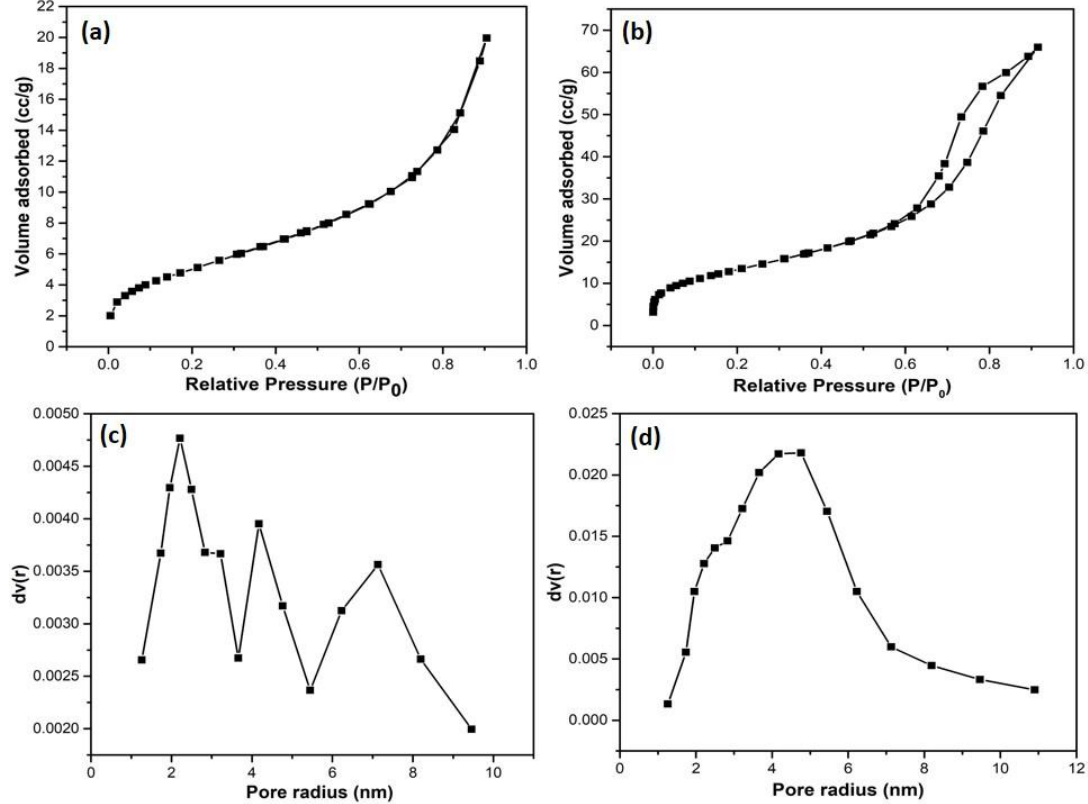
Figure 5. N 2 adsorption–desorption isotherm of ( a ) Bi 2 WO 6 and ( b ) Bi 2 WO 6 / C-dots / TiO 2 . BJH curve displaying pore size distribution of ( c ) Bi 2 WO 6 and ( d ) Bi 2 WO 6 / C-dots / TiO 2 .